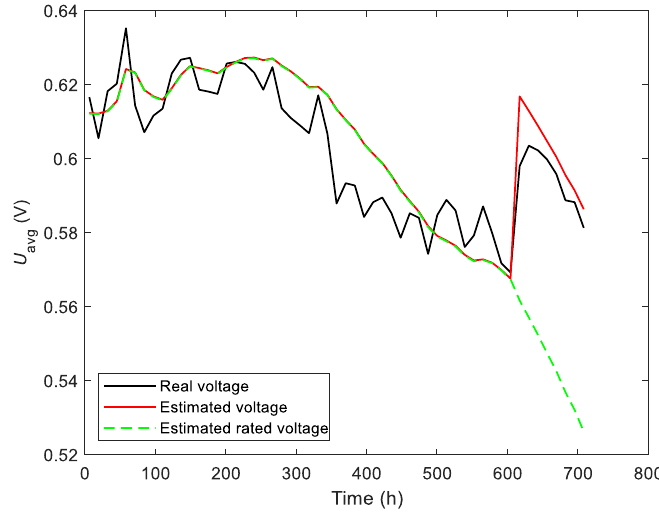
Figure 7. Voltage estimation.